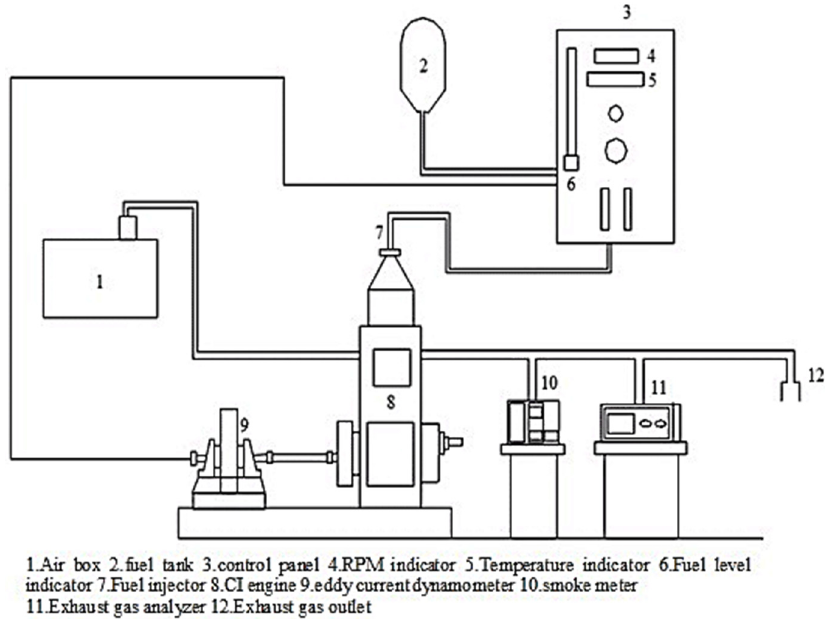
Figure 1. Schematic diagram of the experimental setup.